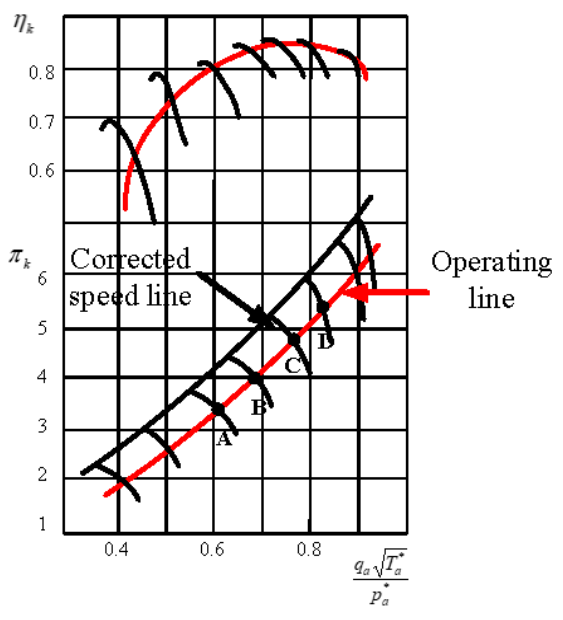
Figure 6. Compressor characteristic curves.